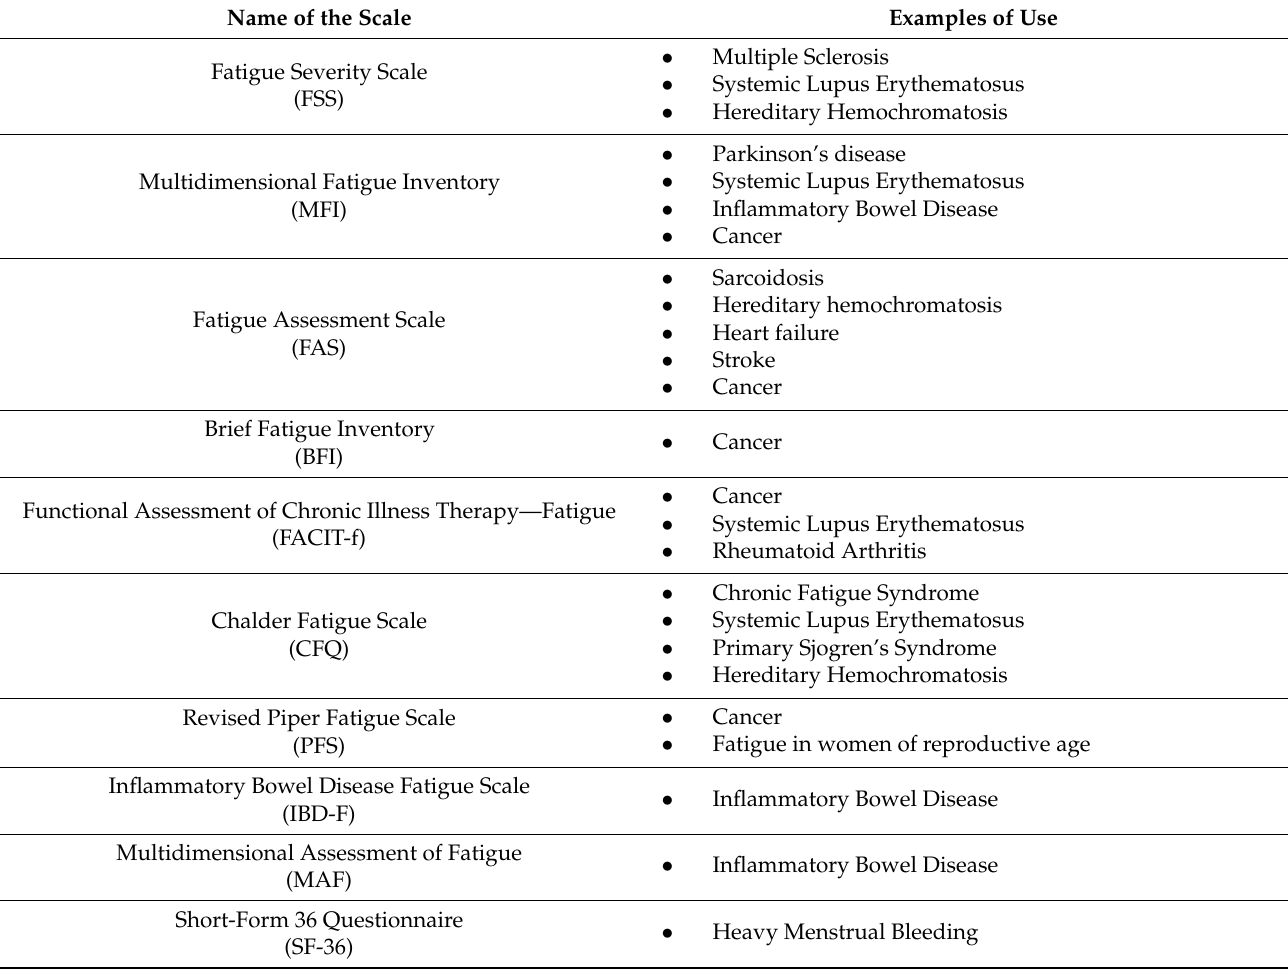
Table 1. Fatigue assessment scales and examples of their use in